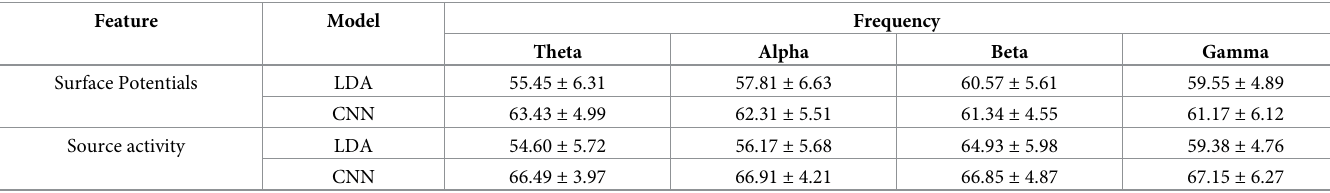
Our results show that it is possible to predict retrieval task performance in a declarative mem- ory task using the reconstructed source activity data with higher accuracy than using surface potentials. Changes in frequency bands have been used to identify later remembered or forgot- ten items presented during the encoding task [2]. Therefore, we evaluated the differences in Table 2. AUC (%) for on-going stimulus